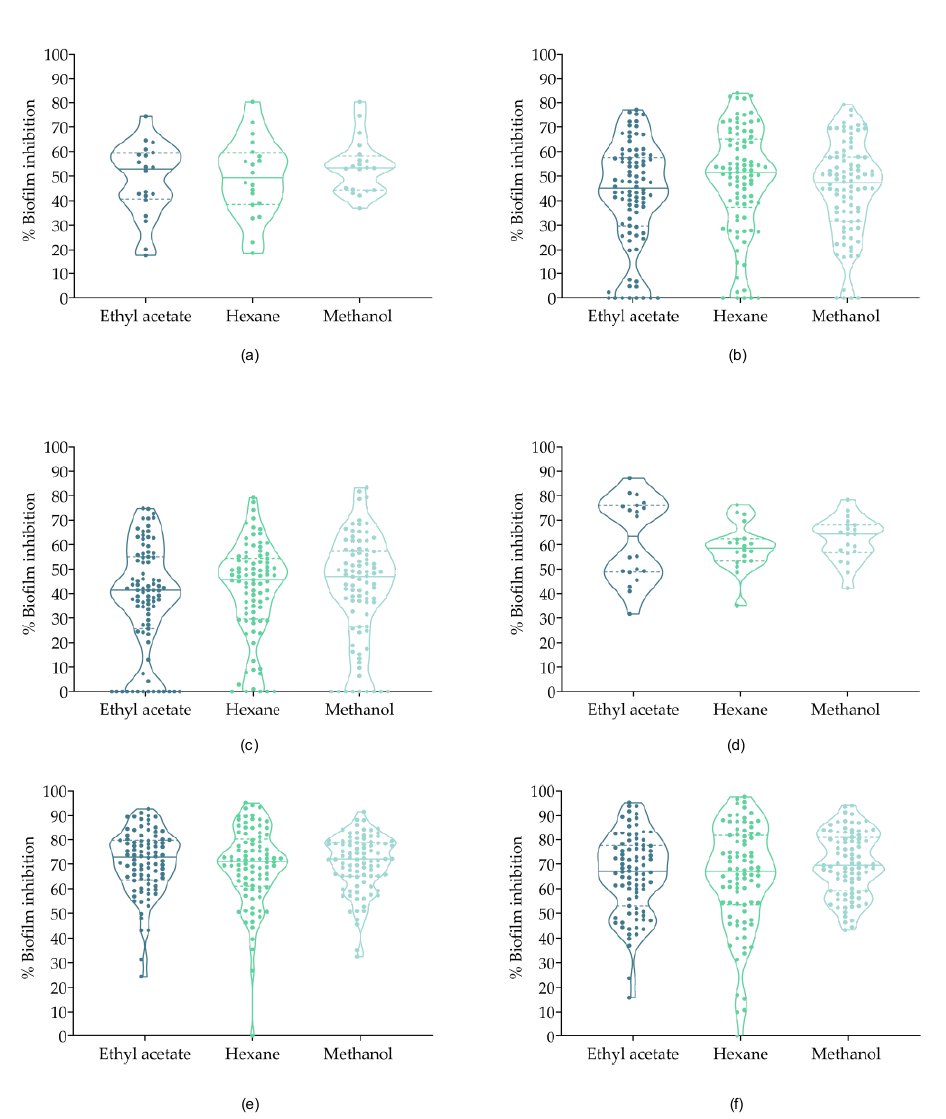
Figure 2. Individual biofilm inhibition ratios of Charophyta , Chlorophyta , and Cyanobacteria extracts against E. cloacae and C. parapsilopsis , represented as percentages. ( a ): Charophyta against E. cloacae ; ( b ) Chlorophyta against E. cloacae ; ( c ) Cyanobacteria against E. cloacae ; ( d ) Charophyta against C. albicans ; ( e ) Chlorophyta against C. albicans ; ( f ) Cyanobacteria against C. albicans .